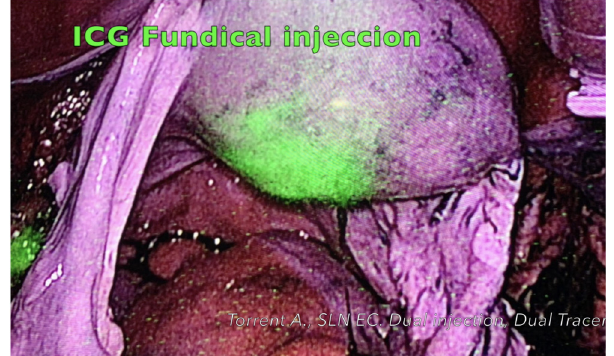
Figure 2. ICG intra-operative fundal injection.